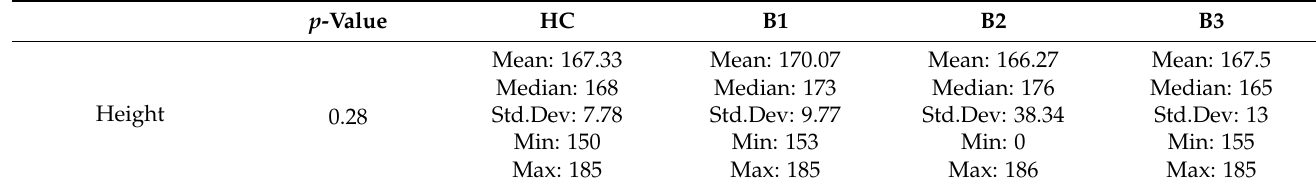
Table A3. Demographic and habits-related parameters of the cohort. The p -values refer to the Kruskall–Wallis test and Fisher’s test between the Montreal B scale and the numeric or categorical variables, respectively. n = No, Y = yes. The variables in bold were unbalanced between the